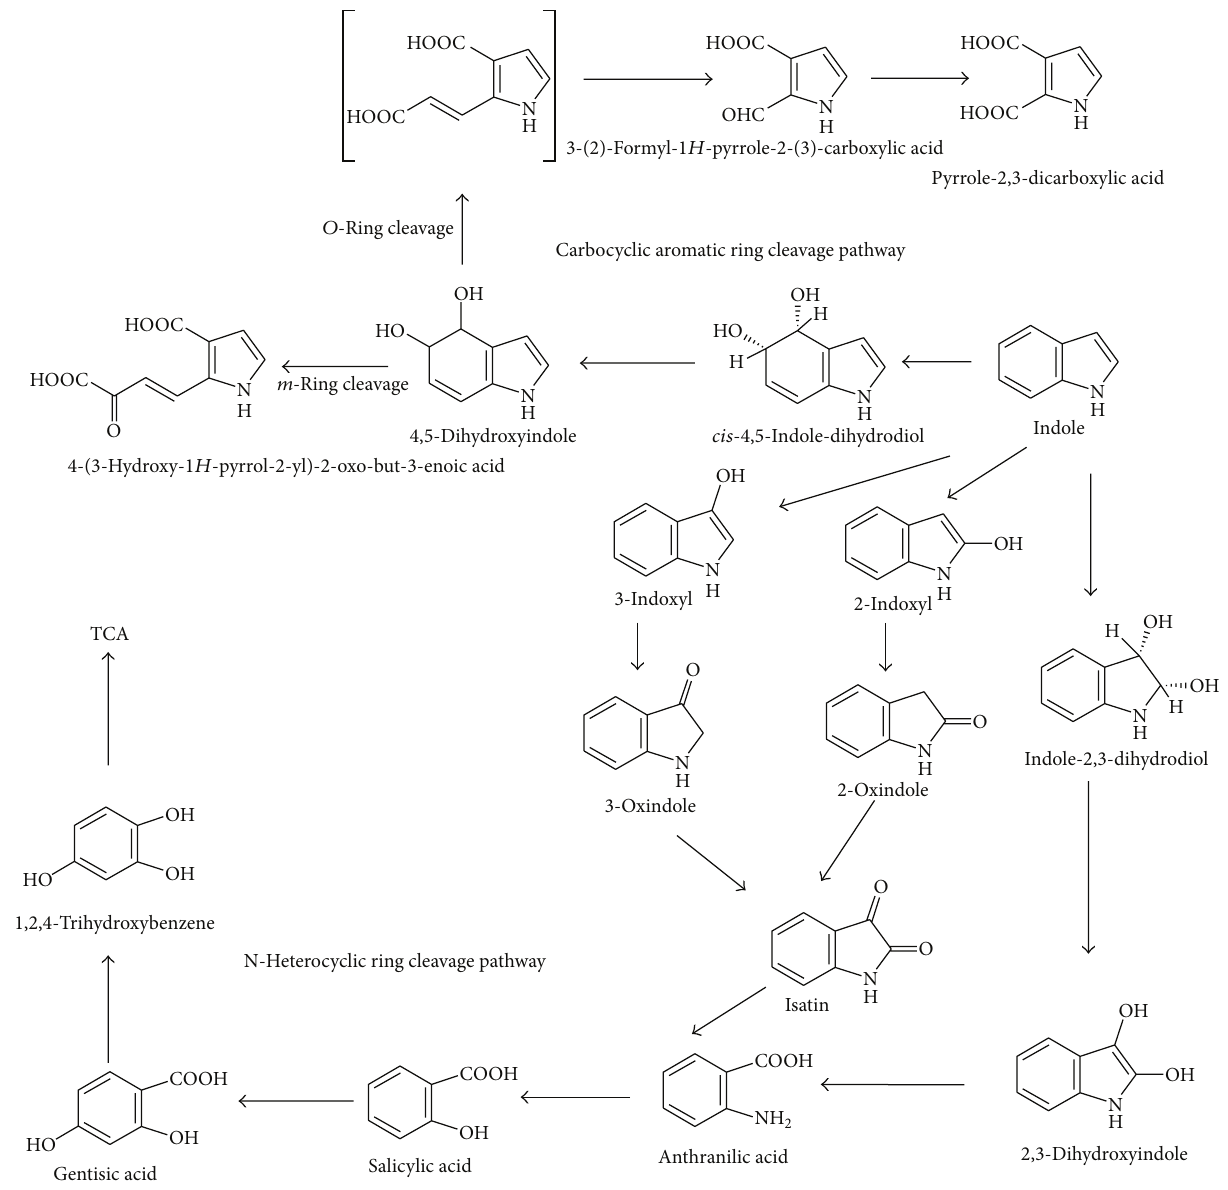
Figure 2: Degradation pathways of indole in Cupriavidus sp. KK10 [34] via carbocyclic ring cleavage and N-heterocyclic ring cleavage.